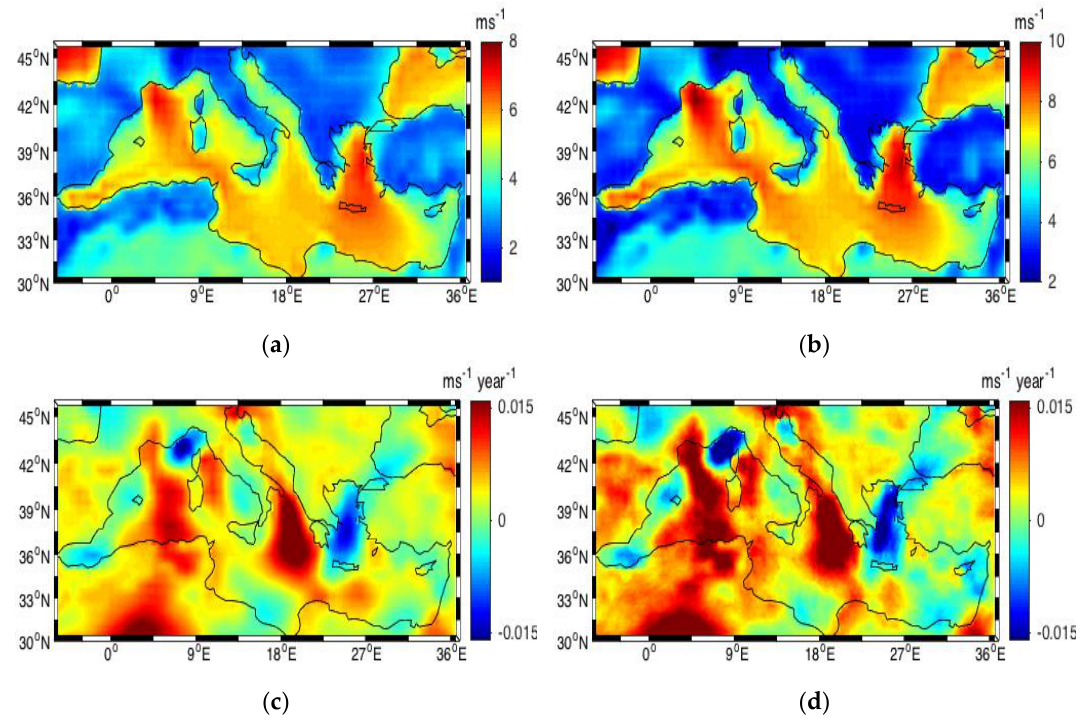
Figure 6. Wind speed: ( a ) 36-year averaged annual mean; ( b ) 36-year averaged annual 75th percentiles; ( c ) trends in the annual mean wind speed; ( d ) trends in the annual 75th percentiles for wind speed. Maps are based on the ERA Interim data (1982 – 2017).